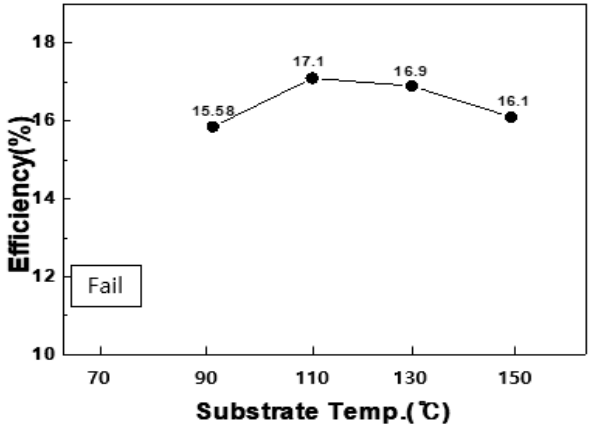
Figure 5. E ffi ciency of CIGSSe solar cells depending on the Zn(O,S) substrate temperatures. Other process conditions: ZnO:ZnS Ratio 4:1, thickness 30nm(cycle Number